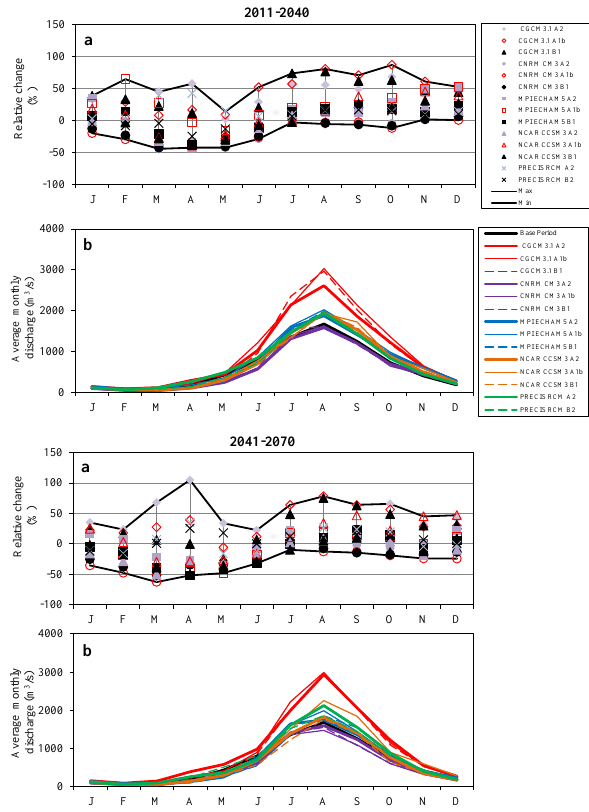
Fig. 13. (a) Change in future monthly sediment yield for all climate projections relative to 1971–2000 and (b) annual sediment yield cy- cle for present (1971–2000) and for all climate projections. Results are for the 2011–2040 and 2041–2070 time